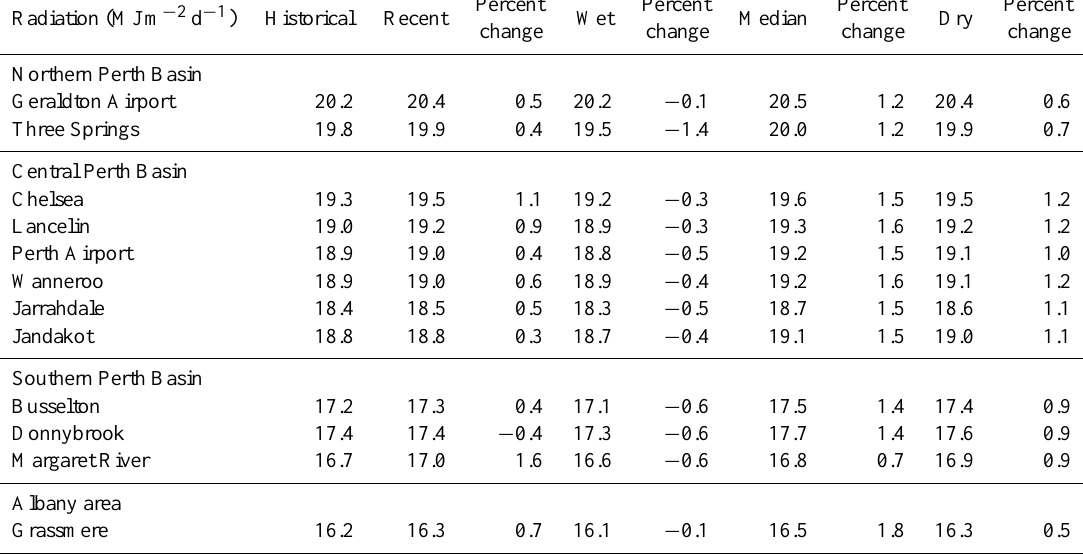
Table 3. Average daily solar radiation (MJm − 2 d − 1 ) for stations in study area, and deviation from historical record. Historical climate is from 1975–2007; recent climate is from 1997–2007; dry climate is from a future simulation derived from INMCM +1.3 ◦ ; median climate is from a future simulation derived from MIROC +1.0 ◦ ; wet climate is from a future simulation derived from GFDL +1.3 ◦